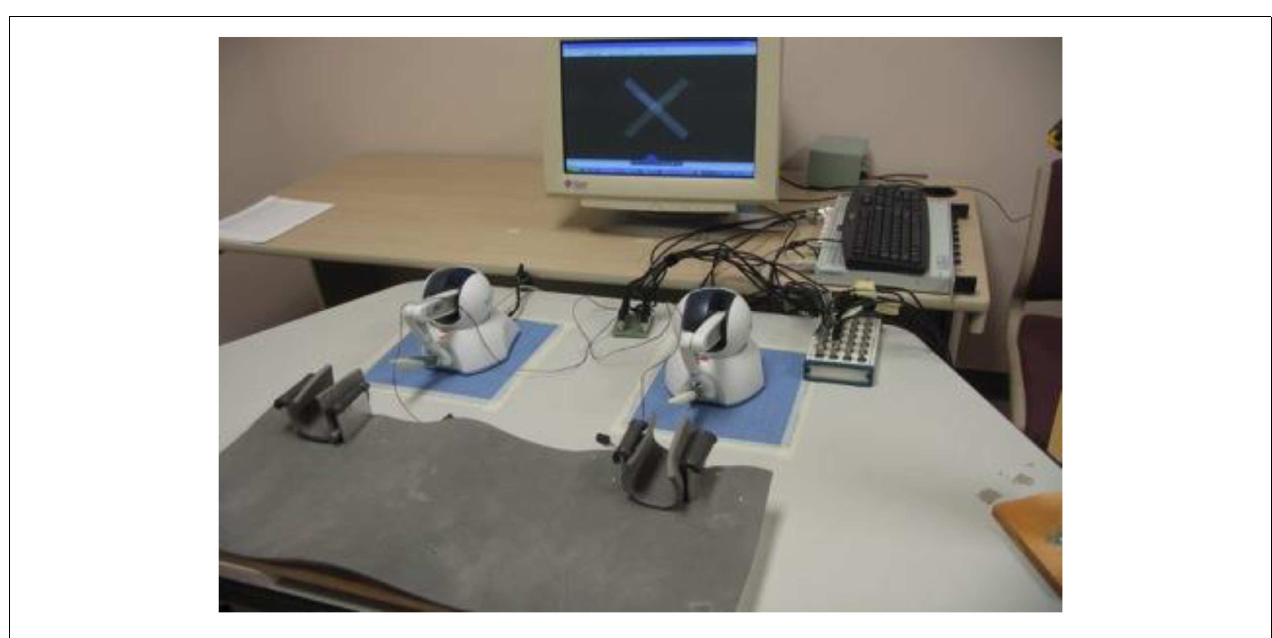
place by the forearm constraints lined with foam padding and grasped the white and blue pen-shaped attachment in their hand with their thumbs on